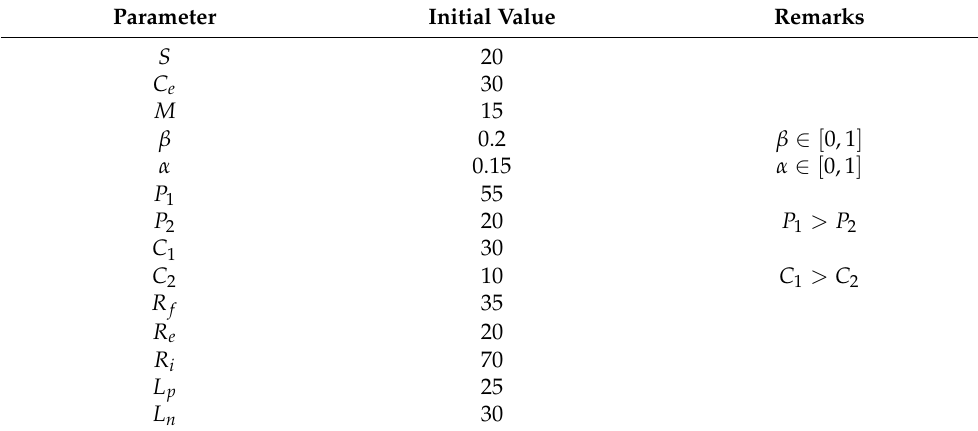
Table 4. Initial values of the parameters of the three-party